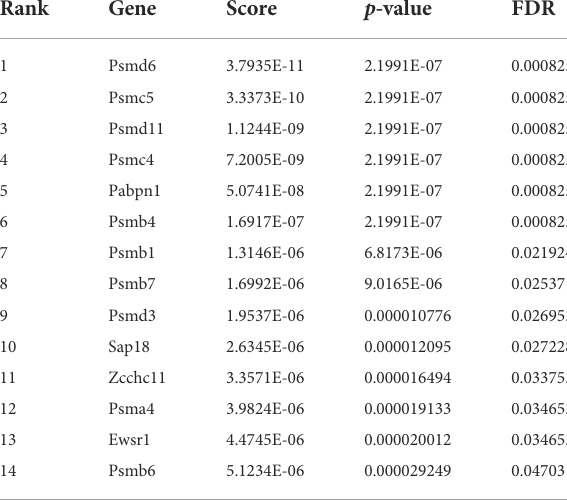
TABLE 4 Genes enriched in RiBi